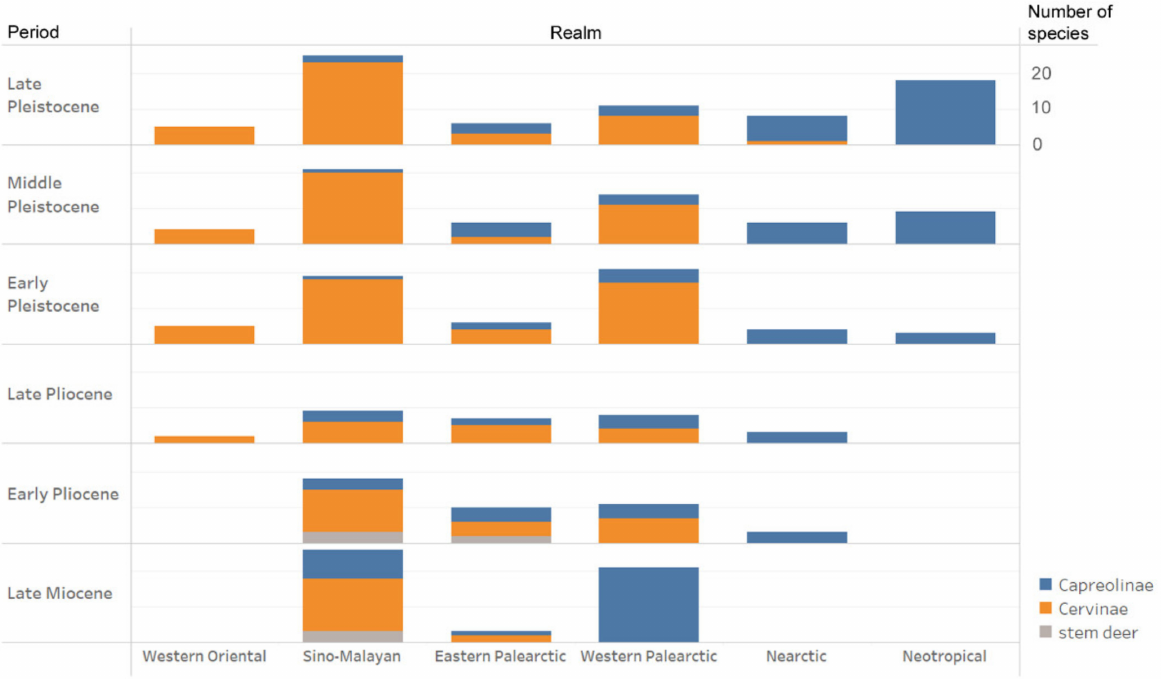
Figure 5. Biogeographic and geochronological distribution of fossil crown Cervidae in the world. The bar height corresponds to a number of